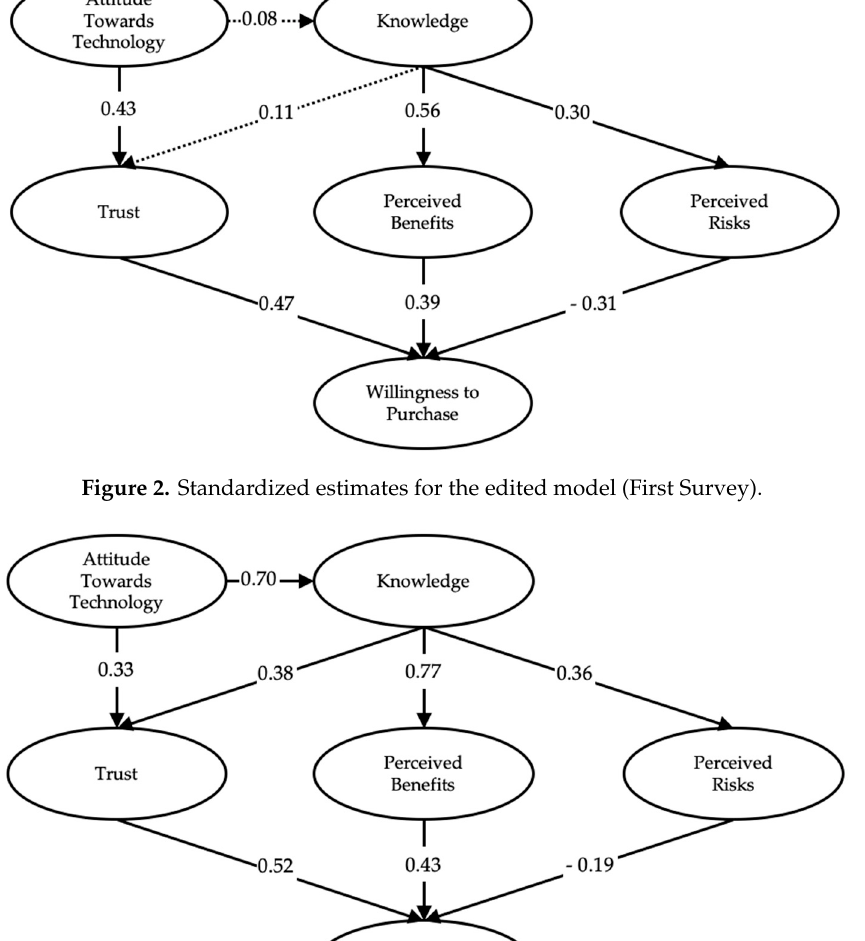
Table 7. Willingness to purchase (N.